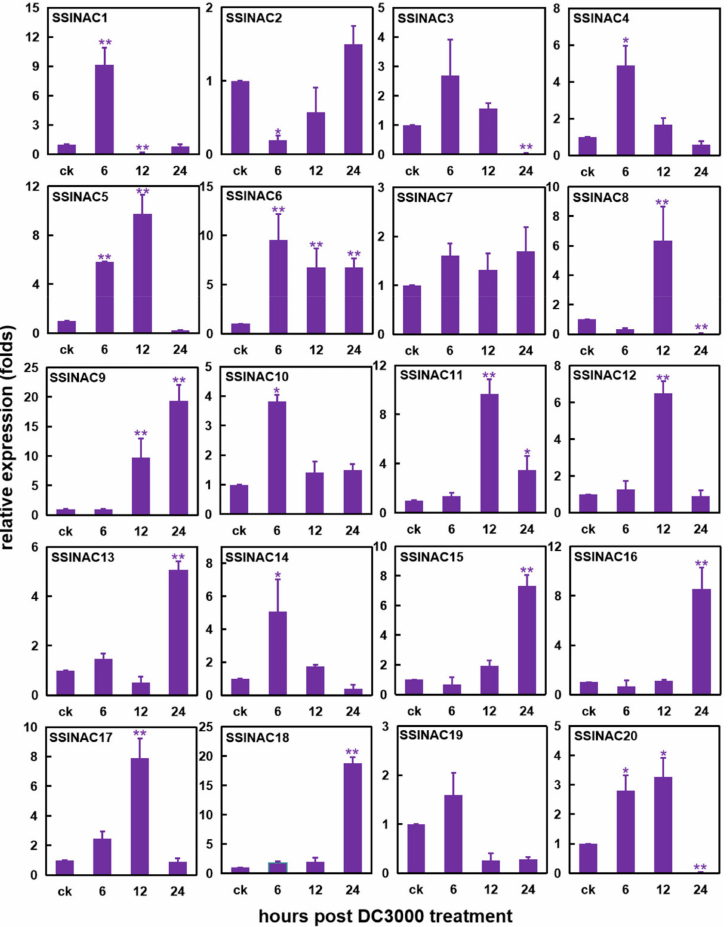
Figure 4. Expression levels of SSlNAC1–20 at 6, 12, and 24 h post Pseudomonas syringae pv. tomato DC3000 ( Pst DC3000) inoculation. The 2 − ∆∆ Ct method was used to calculate the expression fold for each SSlNAC gene. Data are the mean ± standard errors (SD) from three independent biological replicates. Error bars indicate standard error. An asterisk (*) represents a significant difference (* p < 0.05, ** p <